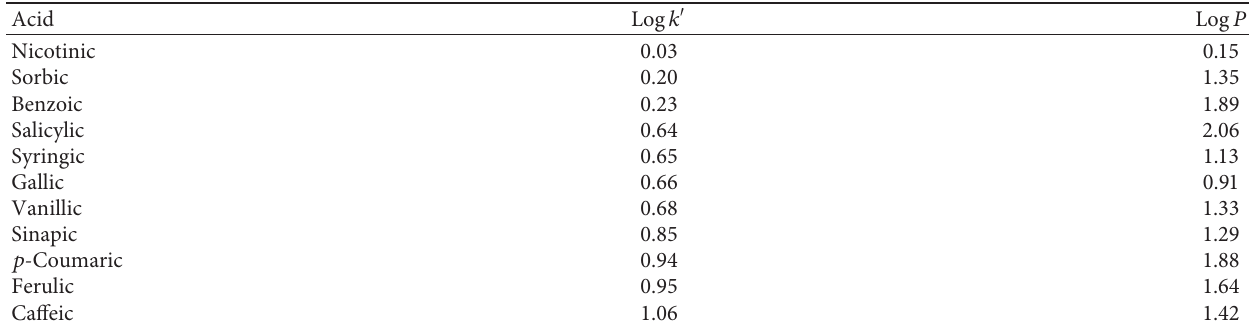
Table 6: Hansch hydrophobicity parameters and PA retention factors on SP-2.